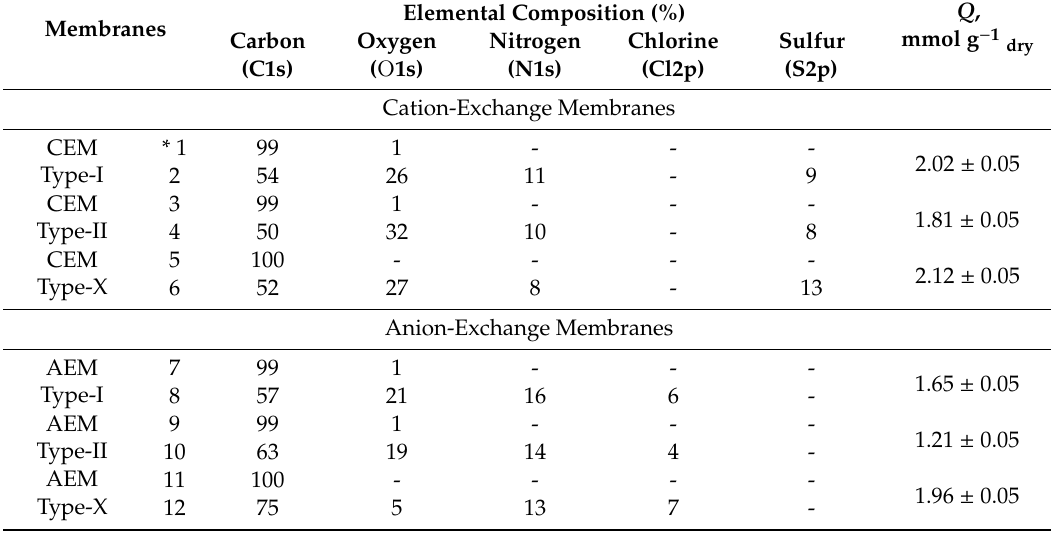
Table 3. The elemental composition (in weight percent) of EN-IEM and their exchange capacity in the air-dry